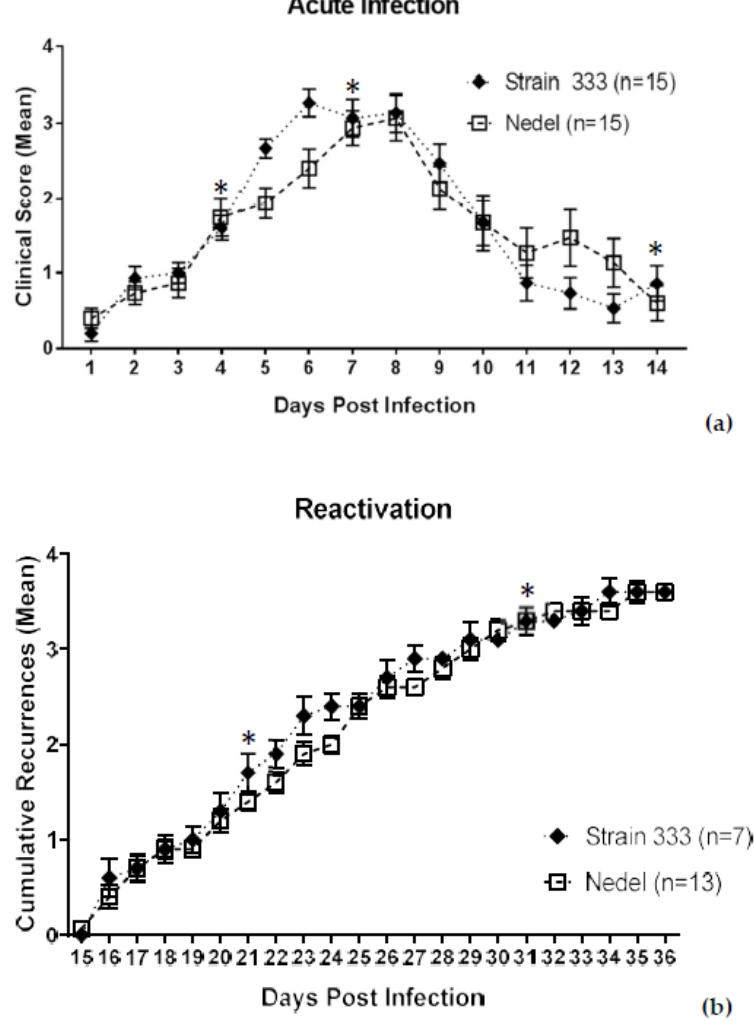
Figure 5. Characterization of Nedel in the guinea pig genital model of HSV infection. ( a ) Acute severity determined by genital lesion scoring on a scale from 0 to 4. Error bars represent SEM. Significance determined by two-way ANOVA, p = 0.79. ( b ) Mean cumulative number of recurrent genital skin lesions per guinea pig. Mean recurrence phenotype was determined by observing genital skin for new lesions. Error bars represent standard error of the mean. Two-way ANOVA, p = 0.93. Asterisks (*) above data points indicate days on which vaginal swabs with subsequent plaque assay were performed. On days 4 and 7, 13/13 Nedel-infected animals and 7/7 Strain 333-infected animals yielded 100% green and non-fluorescent plaques respectively. On day 14, 0% animals shed detectable virus. On both days 21 and 31, 2/13 of the Nedel-infected and 1/7 Strain 333-infected animals yielded 100% green plaques and 100% non-green plaques, respectively.